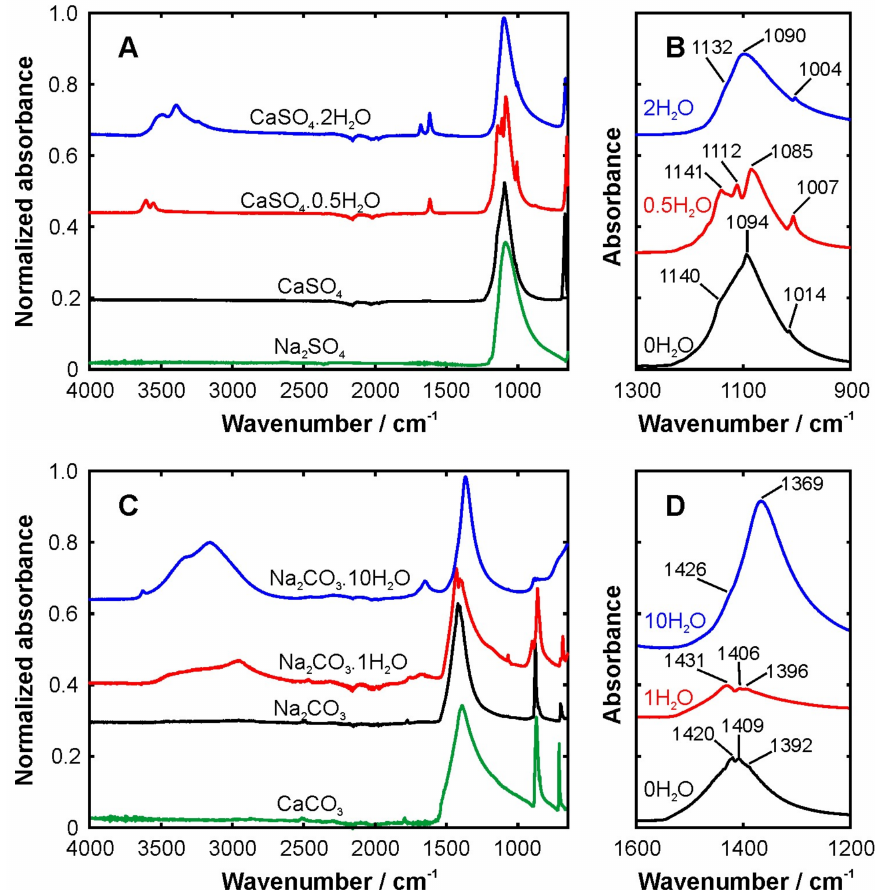
Figure 2. Fourier-transform infrared (FTIR) spectra (650–4000 cm − 1 ) of the pure reference materials. Panel ( A ) shows the different sulfates and panel ( C ) shows the different carbonates. In panel ( B ), the strong sulfate peak around 1100 cm − 1 is shown enlarged and without amplitude normalization for the calcium salts. In panel ( D ), the strong carbonate peak around 1400 cm − 1 is shown enlarged and without amplitude normalization for the sodium salts.